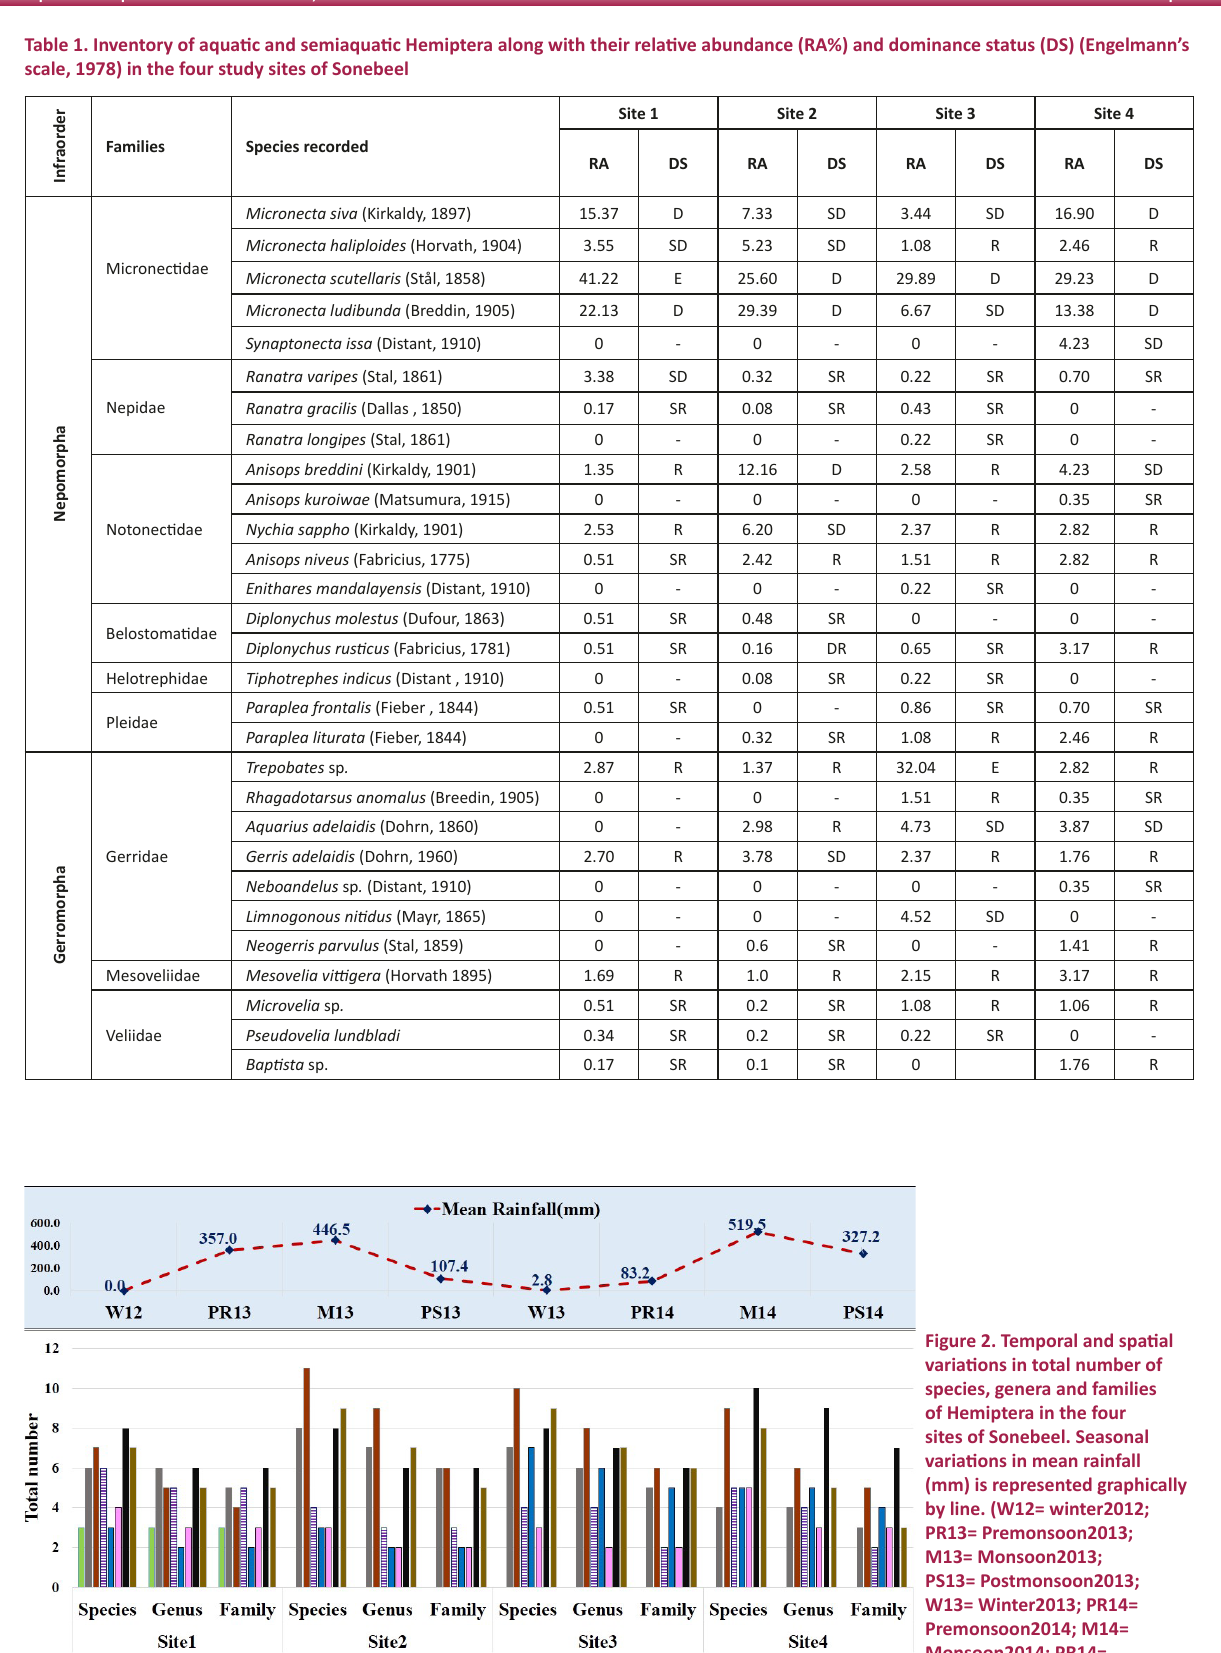
Figure 2. Temporal and spatial variations in total number of species, genera and families of Hemiptera in the four sites of Sonebeel. Seasonal variations in mean rainfall (mm) is represented graphically by line. (W12= winter2012; PR13= Premonsoon2013; M13= Monsoon2013; PS13= Postmonsoon2013; W13= Winter2013; PR14= Premonsoon2014; M14= Monsoon2014;